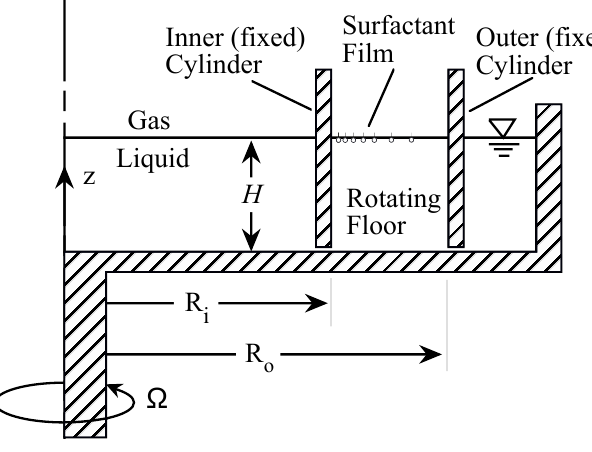
Figure 8. Schematic of the deep-channel surface